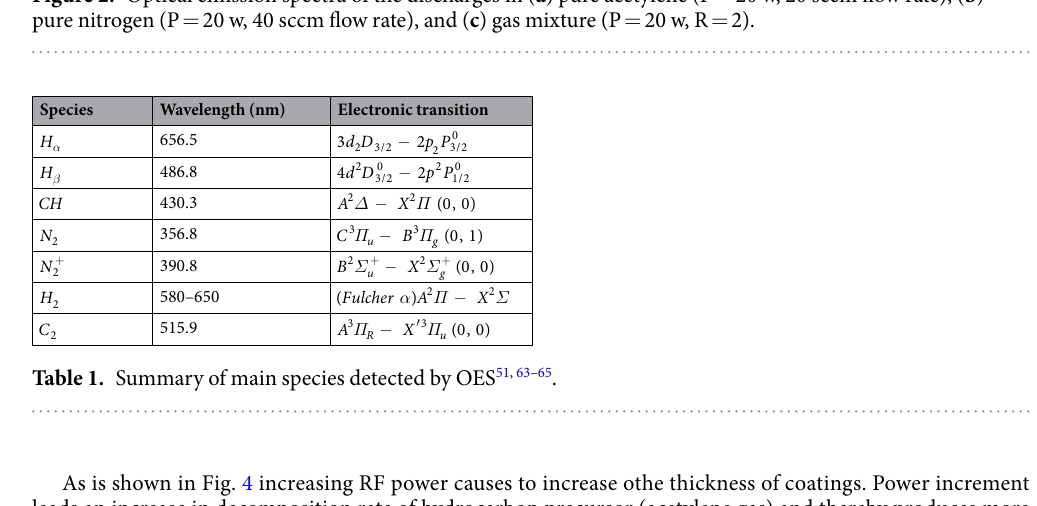
As is shown in Fig. 4 increasing RF power causes to increase othe thickness of coatings. Power increment leads an increase in decomposition rate of hydrocarbon precursor (acetylene gas) and thereby produces more hydrogen-free radicals, with high cohesion coefficient, on the surface 43 . On the other hand with increasing